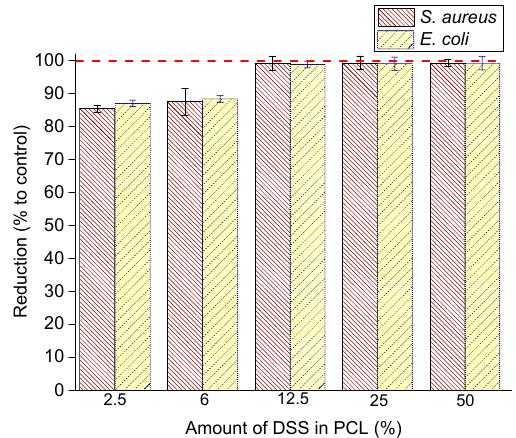
Figure 7. Antibacterial activity of DSS-loaded PCL mats: PCL/2.5%DSS, PCL/6%DSS, PCL/12.5%DSS, PCL/25%DSS, and PCL/50%DSS fibrous mats against S. aureus and E. coli . The results of antimicrobial activity and reductions are listed in Table 5.